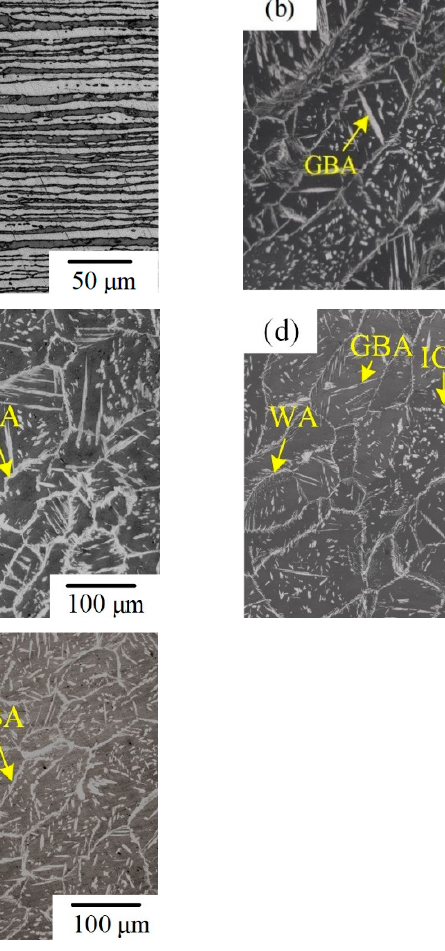
Figure 5. Microstructure of 2205 DSS K-TIG welded joint. ( a ) BM. WMZ under different welding speeds (mm/min): ( b ) 280, ( c ) 300, ( d ) 320, and ( e )